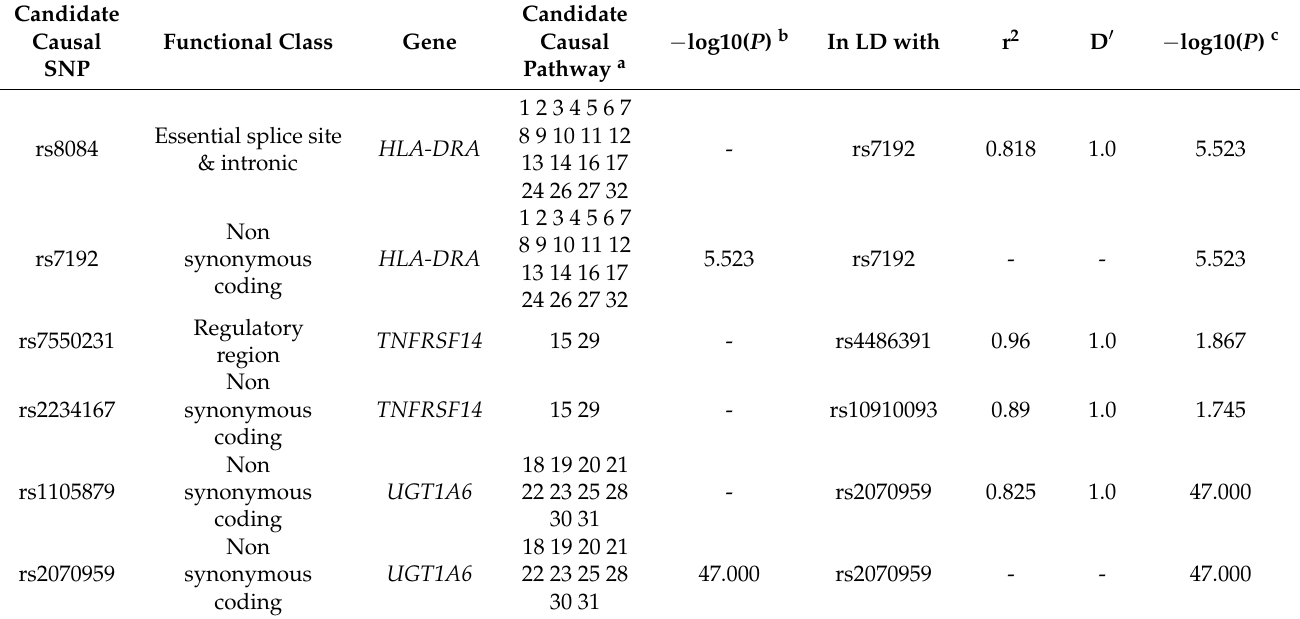
Table 1. Candidate SNPs associated with male